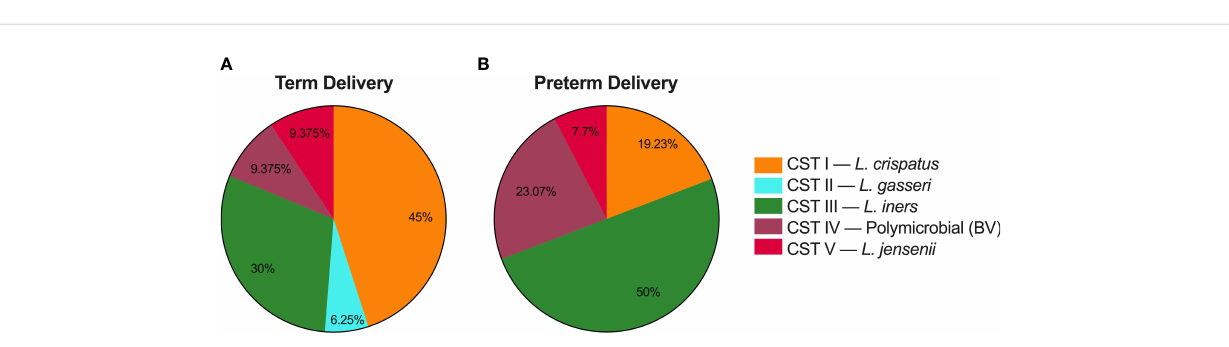
FIGURE 4 Delivery times based on CVM microbial composition for samples collected as part of this study. (A) Percentage of samples from participants who delivered at term that were characterized as community state type (CST) I, CST II, CST III, CST IV, and CST V. (B) Percentage of samples from participants who delivered prematurely that were characterized as each